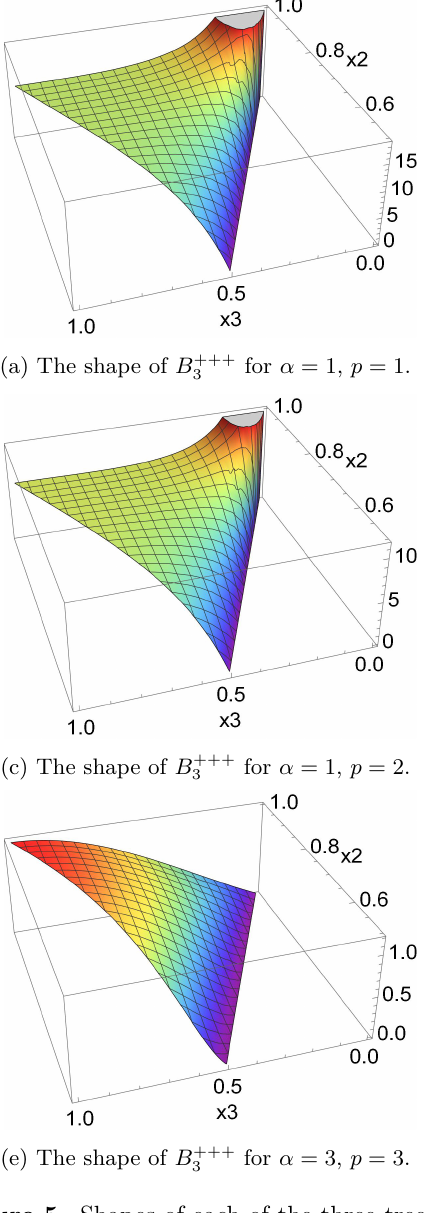
Figure 5. Shapes of each of the three tree-level, contact parity-odd bispectra consistent with the